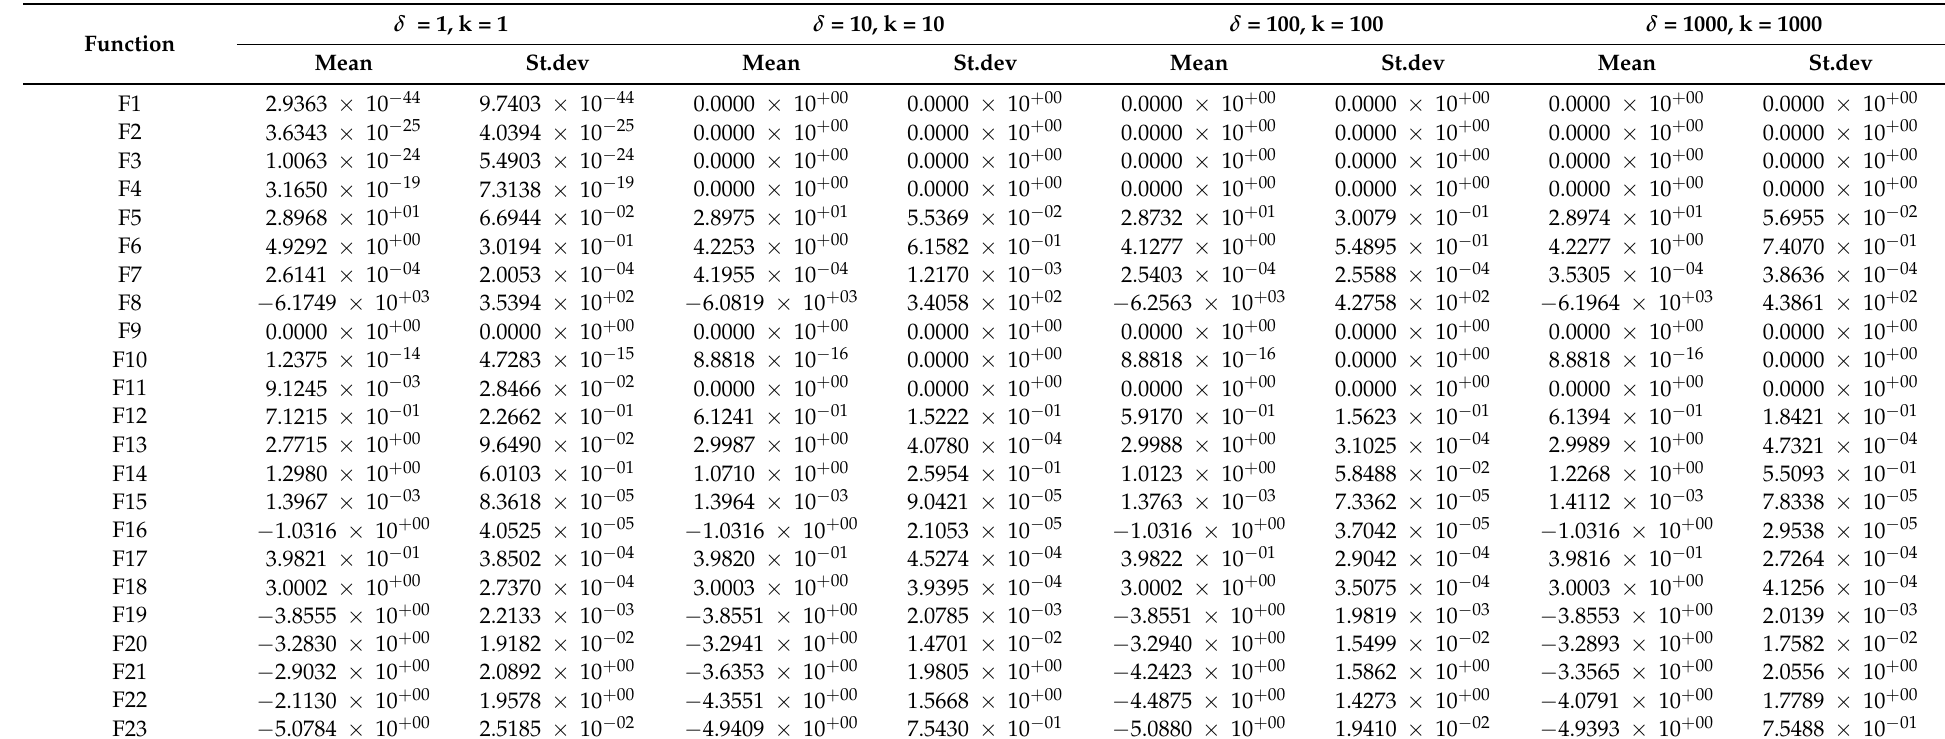
Table 9. Experimental results of RL-ChOA using different combinations of k and δ